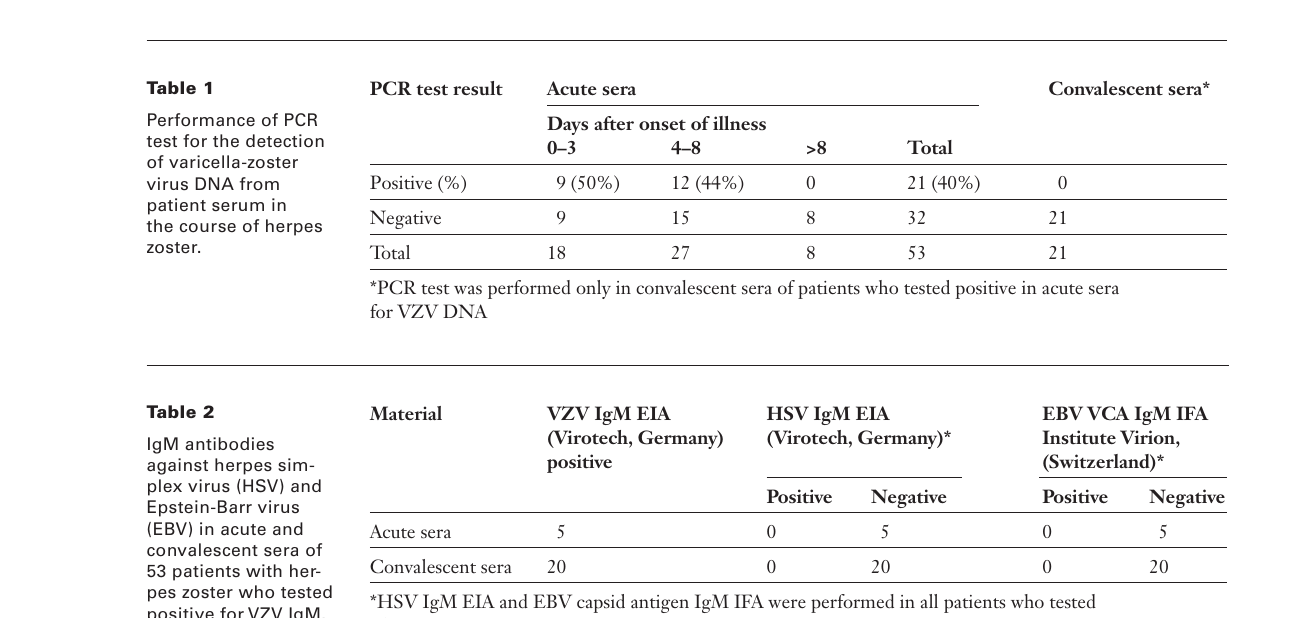
Figure 1 Immune response to varicella-zoster virus in acute and conva- lescent sera from 53 adult patients with acute herpes zoster, based on indirect fluo- rescent antibody IgG test (IFA IgG; top) and complement fixa- tion test (CF; bottom). Acute and convales- cent paired sera, in whom seroconver- sion or a fourfold or greater titre increase was observed [41 (77%) by CF and 43 (81%) of 53 samples by IFA IgG], are linked for each indi- vidual patient. Data for the analysis of an- tibody titres were log-transformed.